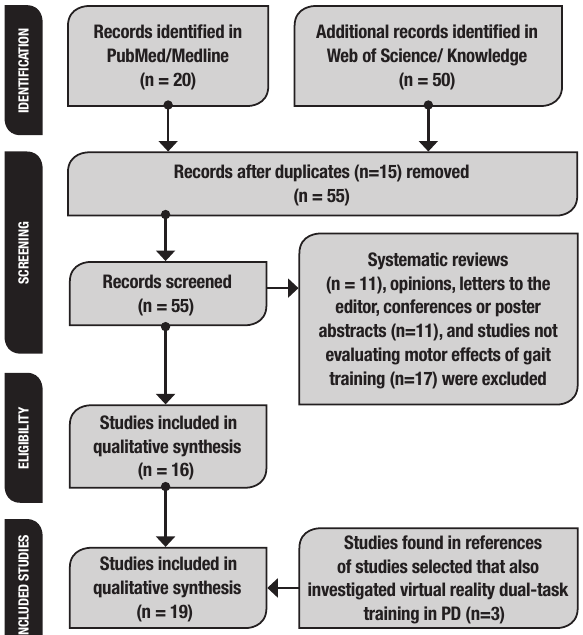
Figure 1. Studies included in systematic review, based on PRISMA criteria (2009): identification, screening, eligibility and studies included in review